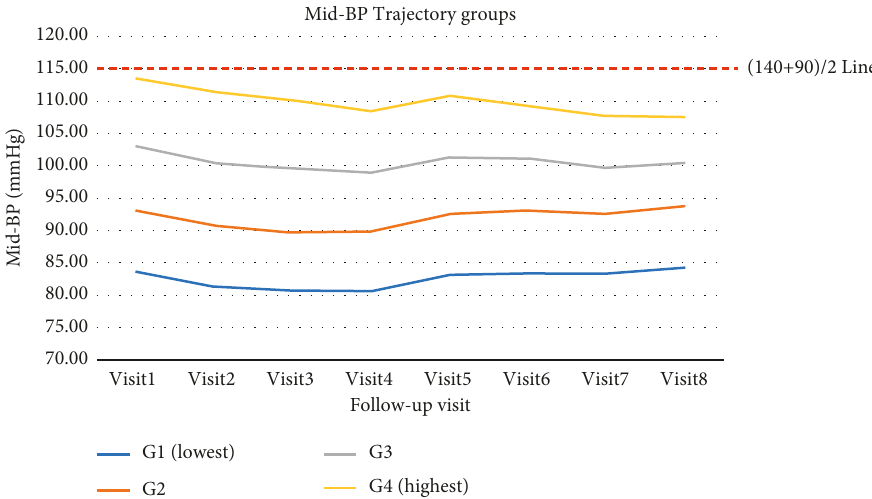
Figure 2: Mid-BP trajectory groups over time. These show mid-BP trajectories for 16 years (from visits 1 to 8) with mid-BP levels of each visit by trajectory groups. Group 1 is the lowest mid-BP group, and group 4 is the highest mid-BP group. Group 2 is the second-lowest mid- BP group and has a value lower than 95mmHg. Group 3 is the third-lowest Mid-BP group and has a value lower than